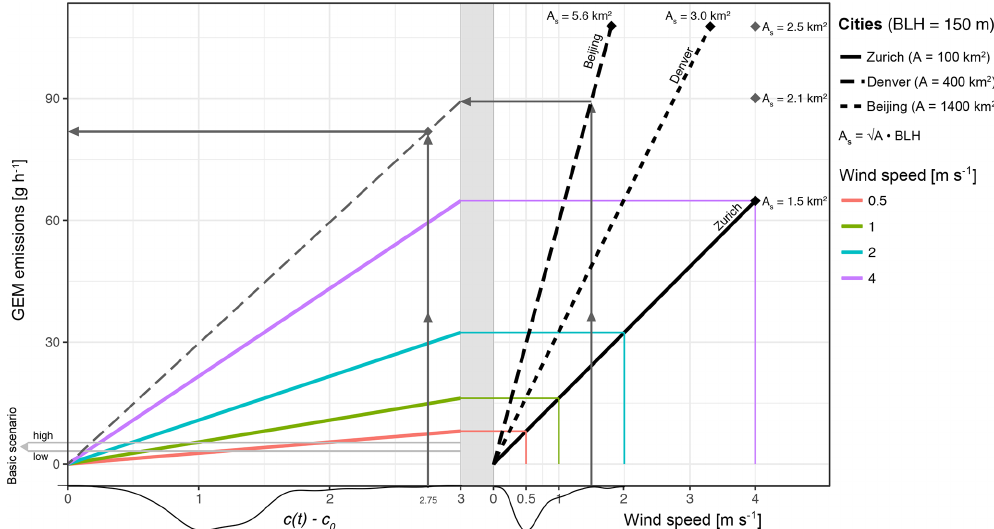
Figure 4. Graphical representation of the steady-state formula E = u · A s · (c − c back ) to estimate emissions in a box model. Starting at different wind speeds, the colors show the corresponding GEM emission estimate for Zurich in relation to the concentration difference between measurement c and background c 0 . The results of the basic emission scenario are given as gray lines. The gray shading highlights the range in concentration differences obtained in Zurich. An example of how emissions are estimated for another city is given for Beijing, with a wind speed of 1.5ms − 1 and 2.6ngm − 3 concentration